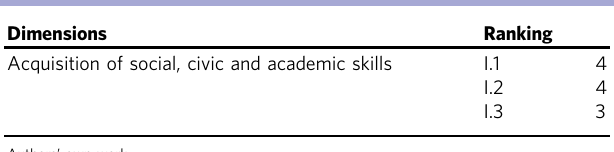
Table 15 Dimensions of the model (TB.5) and level of development for each initiative.